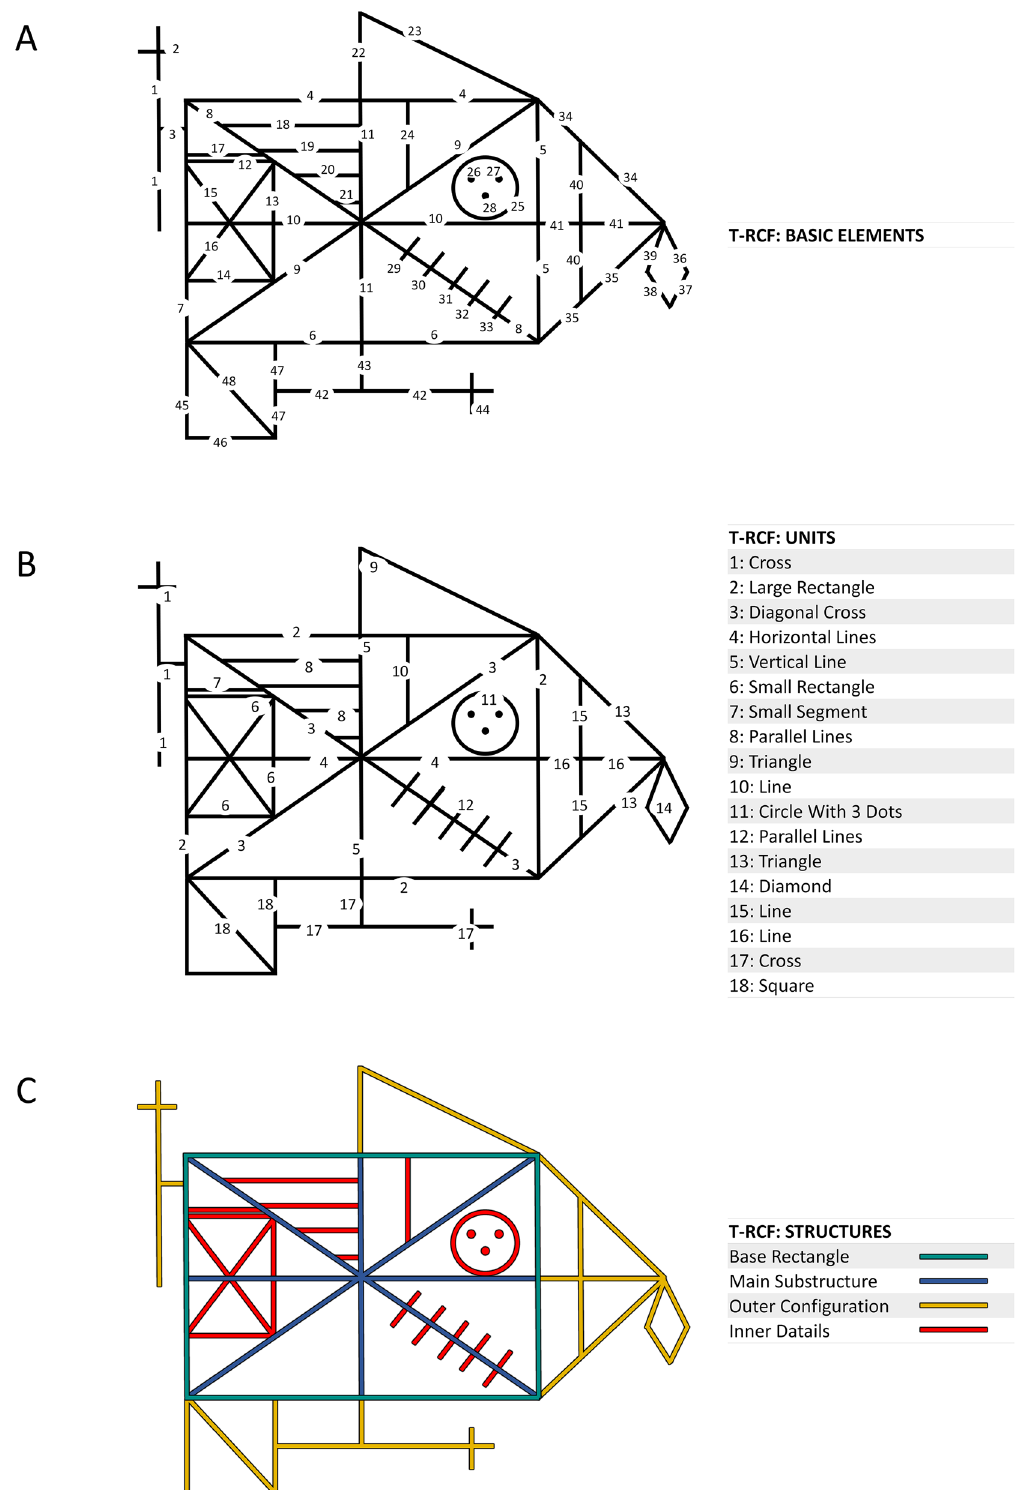
Figure 1. Three classifications of constitutive parts of the T-RCF. ( A ) Division into basic elements: the T-RCF (i.e., Tablet-based Rey complex figure) is divided into 48 basic elements. ( B ) Division into units: the T-RCF is divided into 18 geometrical units according to the classical classification 5 . ( C ) Division into structures: the T-RCF is divided into the 4 main constitutive structures according to the classification of Trojano et al. 63 . The figure is a reproduction of the RCF 5 created assembling geometric elements with Microsoft PowerPoint (Microsoft Office 365 Version 2105; www. office.